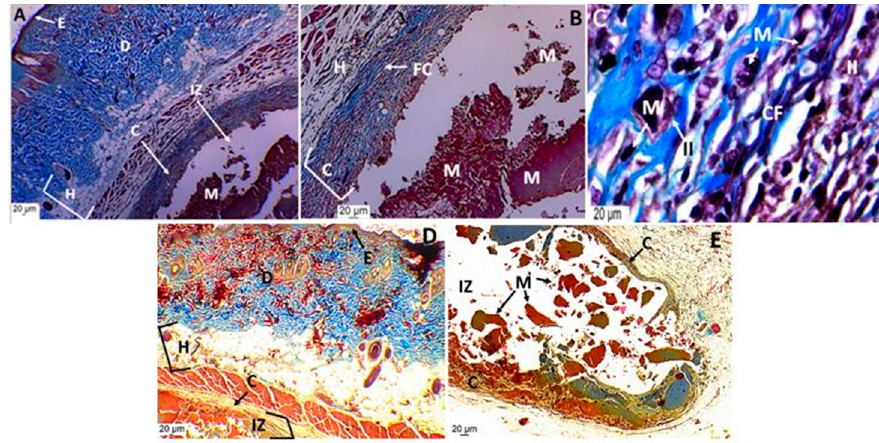
Figure 13. Histological analysis of experimental sample F5 (29.00 CS / 70 PVA / 1.0 ox-CNO). Magnifications are as follows: ( A ) 4 × ; ( B ) 10 × ; ( C ) 40 × ; ( D ) 4 × ; ( E ) 40 × . E: Epidermis; D: Dermis; H: Hypodermis; C: Capsule; IZ: Implantation zone; M: Material; II: Inflammatory infiltrate. ( A – C ) correspond to sample F5 stained using hematoxylin and eosin. ( D , E ) correspond to sample F2 stained using Masson’s trichromacy.